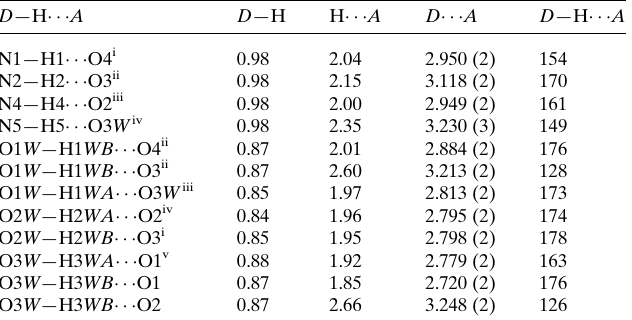
Table 2 Hydrogen-bond geometry (A˚ , (cid:3) ) for (I).